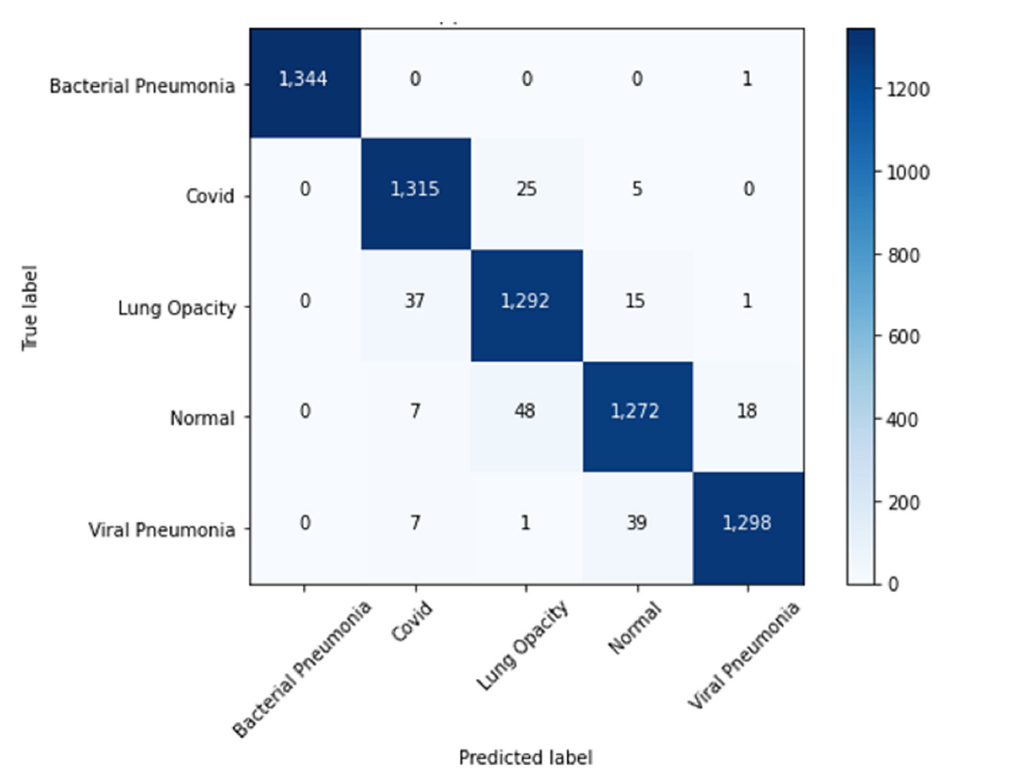
Figure 6. Overlapped confusion matrix of 5 ‐ class classifications. Table 4. Performance of FirecovNet on each fold in the 4 ‐ class classification tasks. Task